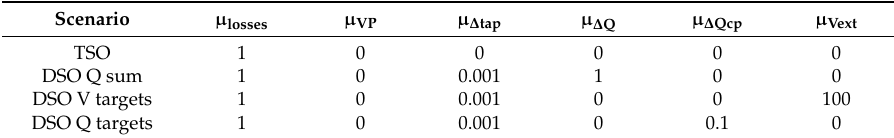
Table 2. OF weights for setpoints comparison.